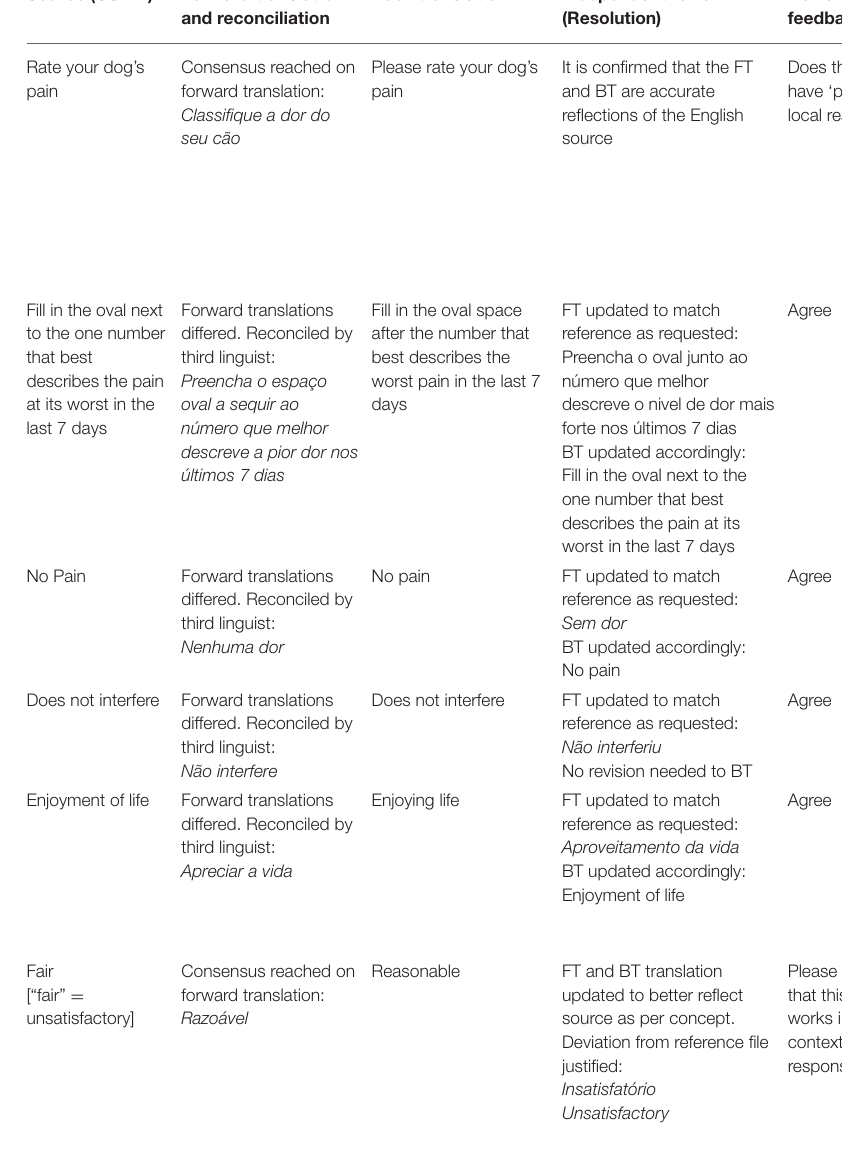
TABLE 1 | Examples of discrepancies and changes in the linguistic validation process for Portuguese. Source